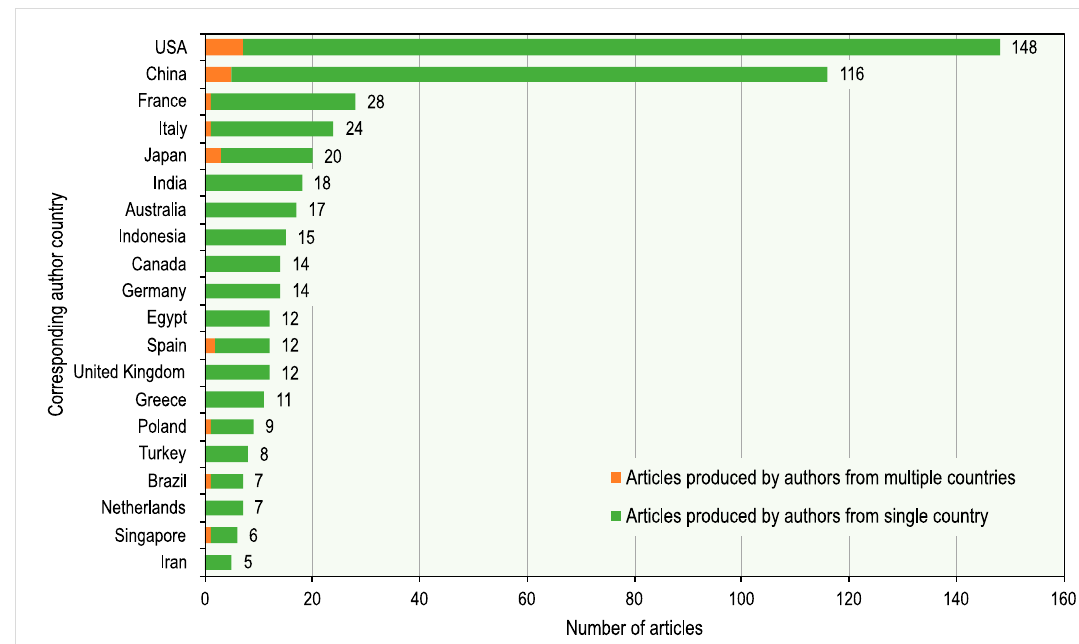
Figure 13. Number of documents by the corresponding author’s country (WoSCC and Scopus da- tabases).